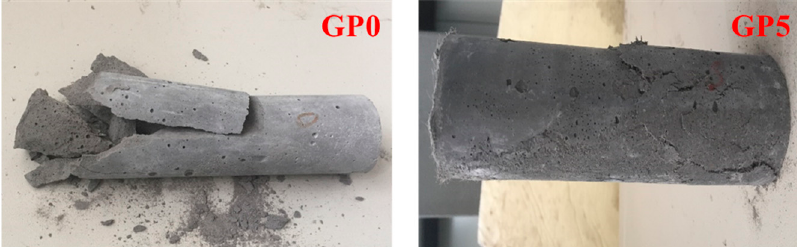
Figure 6. Failure modes of GP0 and GP5 specimens.